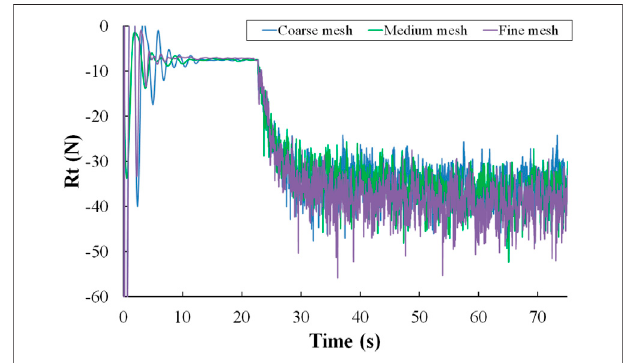
FIGURE 6 | Time history curves of the total resistance of the three grids.